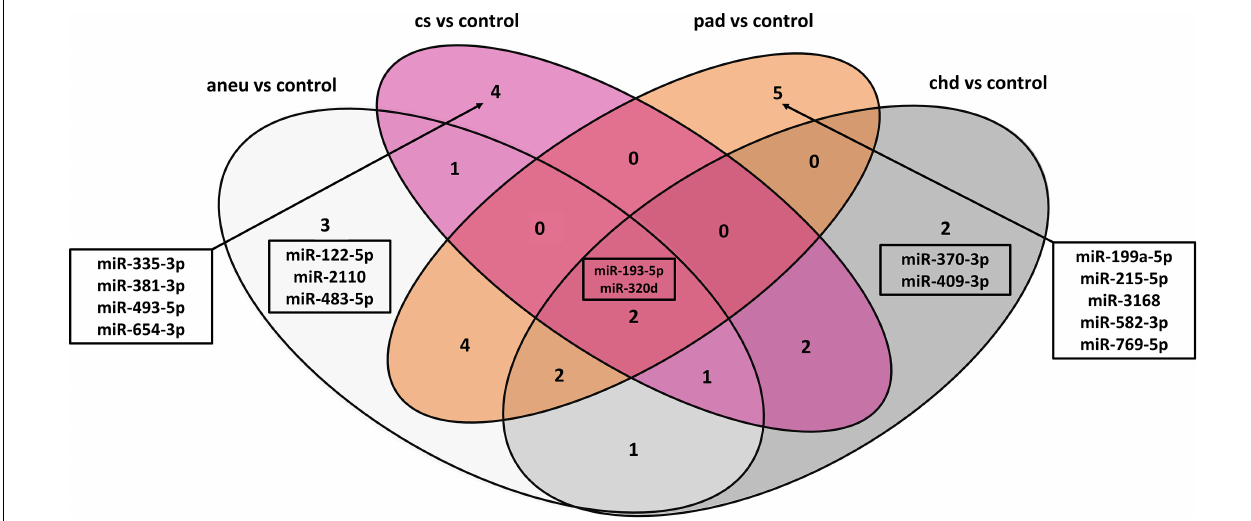
FIGURE 4 | Venn-diagram representing the result of the overlap analysis; aneu = abdominal aneurysm; chd = coronary heart disease; cs = carotid stenosis; pad = peripheral artery disease.